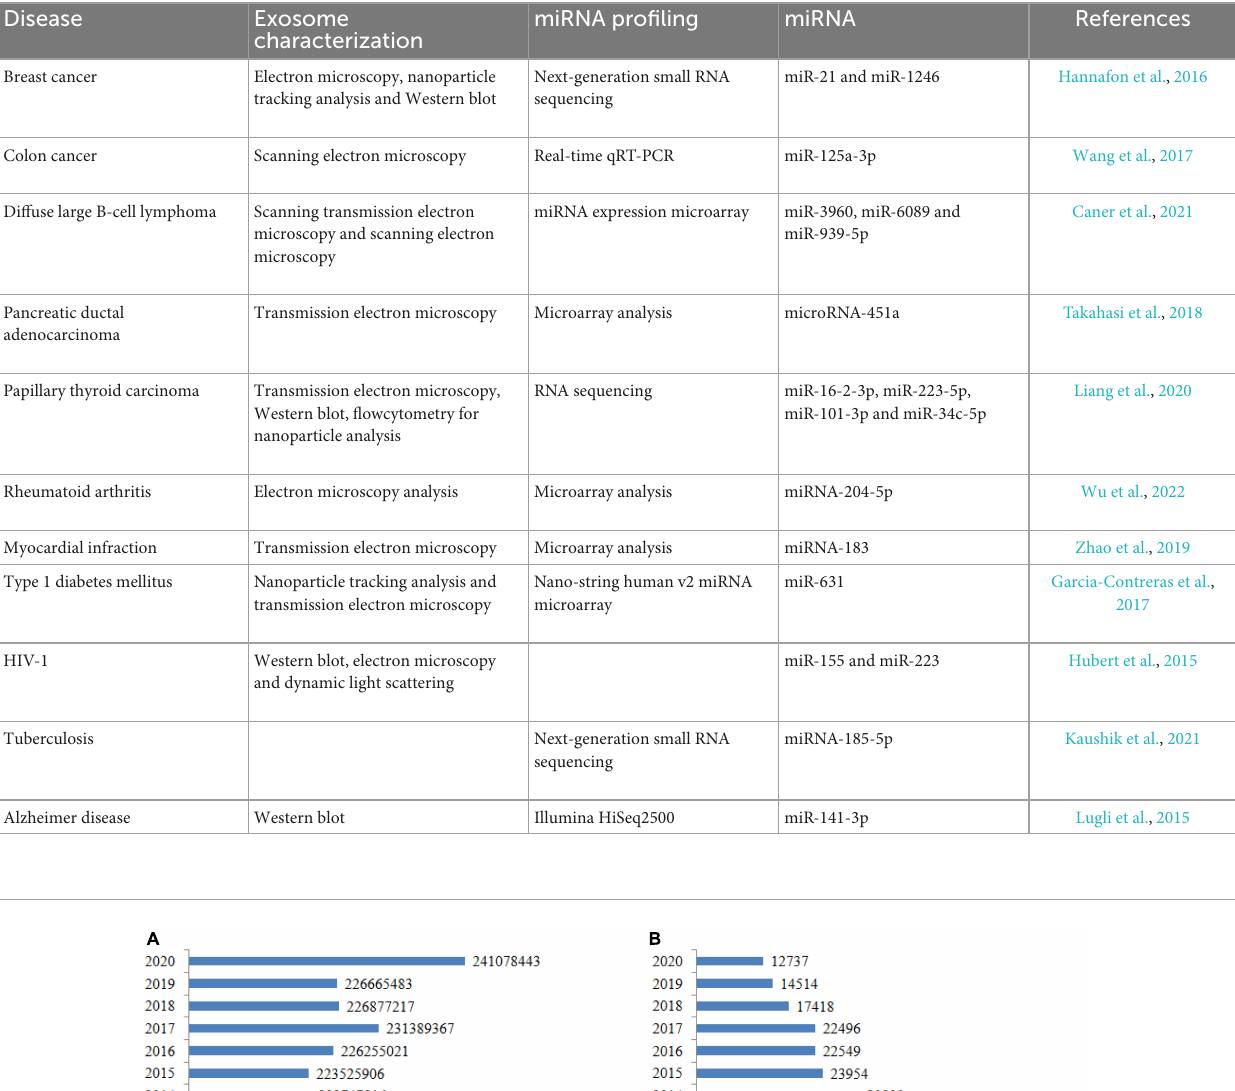
TABLE 1 Plasma-derived exosomal miRNA expression in various diseases.